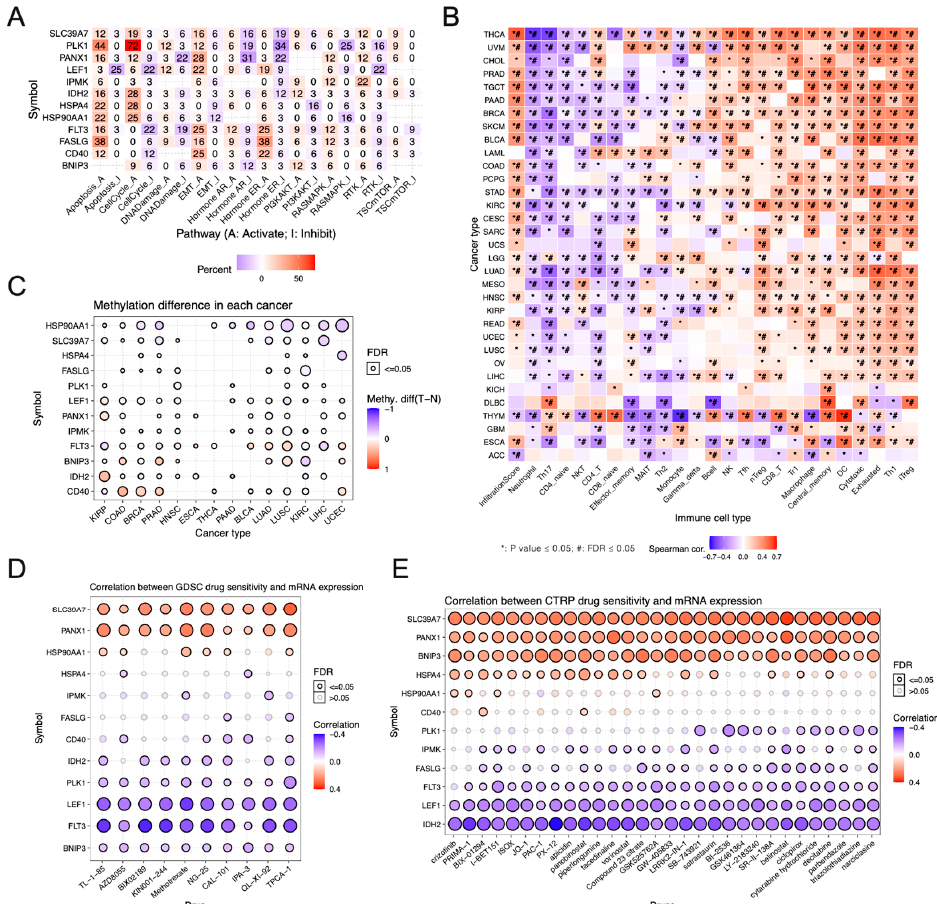
Figure 7. The relationship between necroptosis-associated risk model genes and cancer signaling pathways, drug sensitivity, and immune cell infiltration. ( A ) This heatmap illustrates the correlation between the genes involved in necroptosis risk assessment and the cancer signaling pathways involved. ( B ) A heatmap depicts the relationship between the genes associated with necroptosis risk and the immune cells present in pan-cancers. Notably, red represents a positive correlation and purple represents a negative correlation. * p ≤ 0.05 and # FDR ≤ 0.05. ( C ) A comparison of the methylation patterns of these necroptosis risk model genes across several types of tumors is shown here. ( D , E ) This table shows the correlation between necroptosis risk model genes and multiple anticancer drug susceptibility in the GDSC and CTRP databases. Red bubbles represent positive correlations, blue bubbles represent negative correlations, and the darker the color, the higher the correlation. The size of the bubbles was positively correlated with FDR significance. Black outline boxes indicate FDR ≤ 0.05.